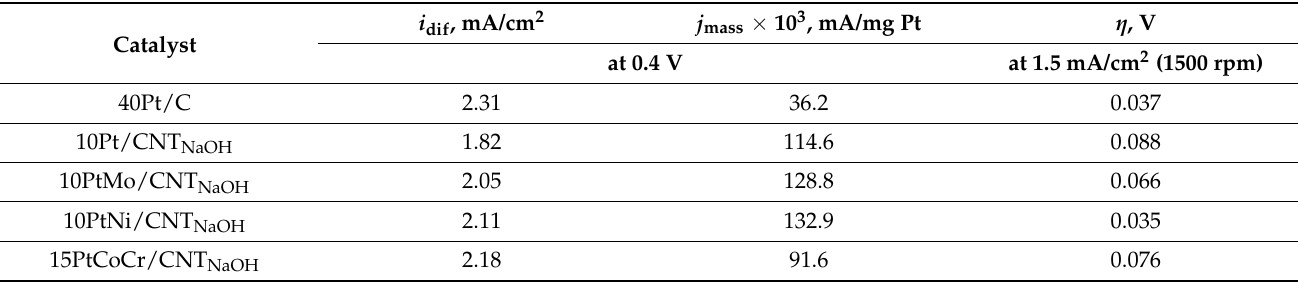
Figure 3. Polarization curves of hydrogen oxidation in 0.1M KOH. 0.005 V/s; 1500 rpm; m cat = 0.15 mg/cm 2 . Table 2. Electrochemical parameters of